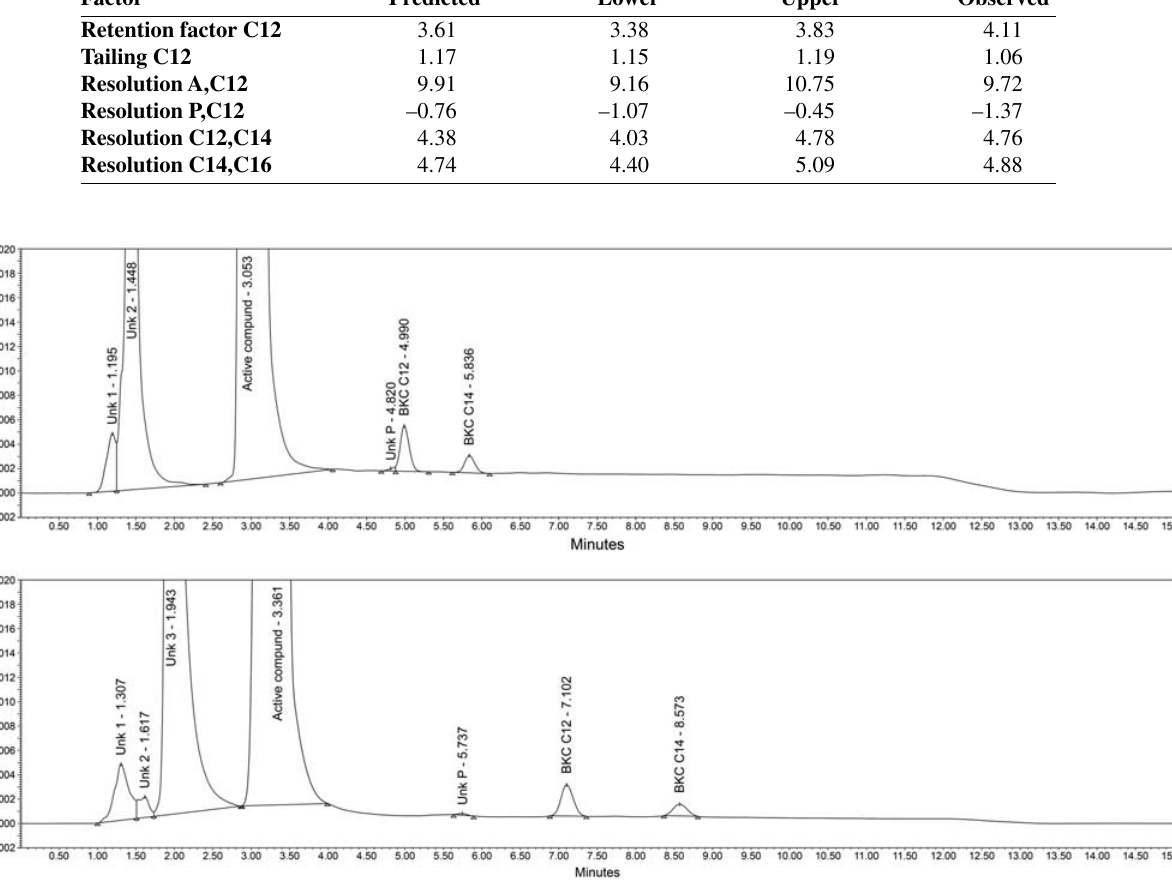
Figure 4. Chromatogram of sample analyzed with initial (top) and optimized (bottom) chromatographic conditions. The interfering placebo peak in the chromatograms is labelled as UnkP and benzalkonium chloride homologs as BKC C12 and BKC